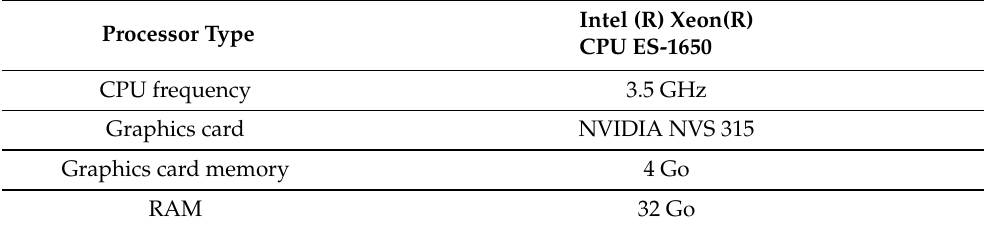
Table 2. Workstation properties for simulation purposes.